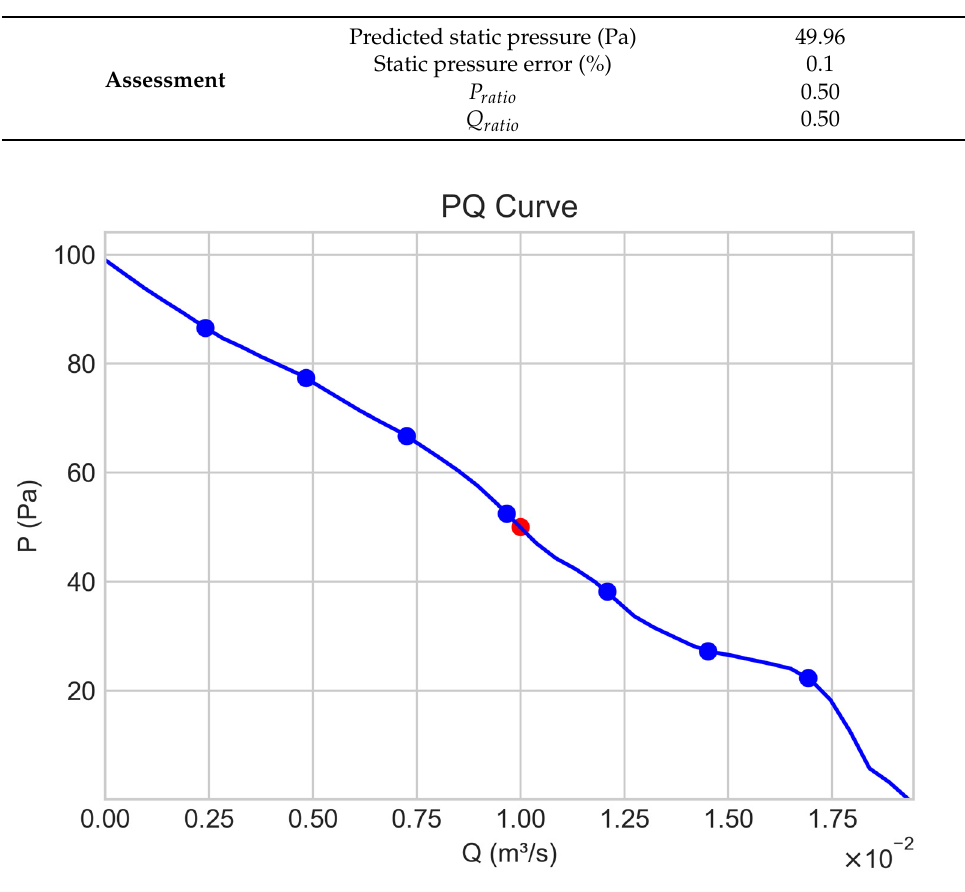
Figure 10. P ‐ Q Curve using optimum design parameter. Figure 10. P-Q Curve using optimum design